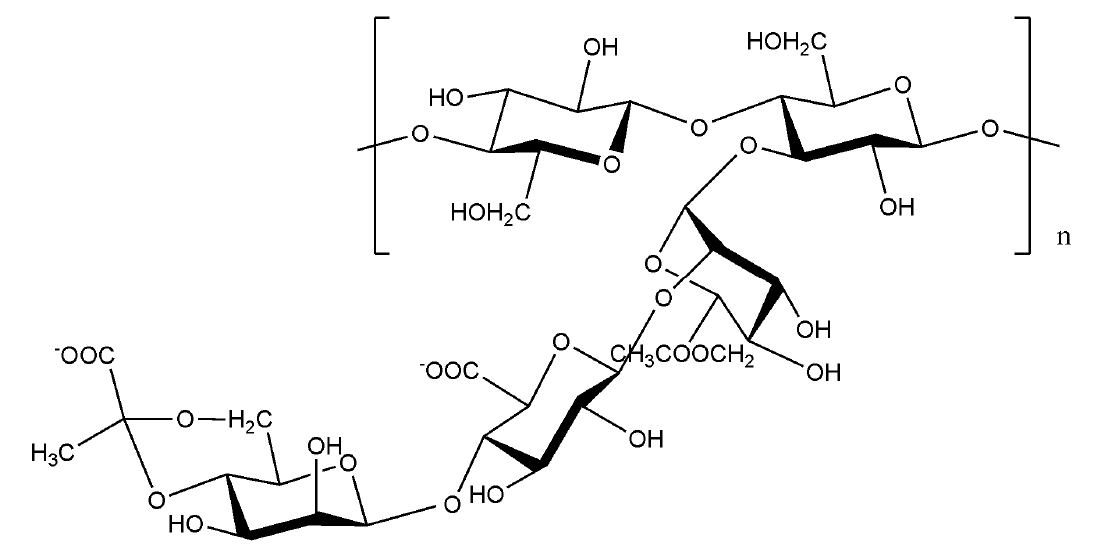
Figure 9. The structure of xanthan